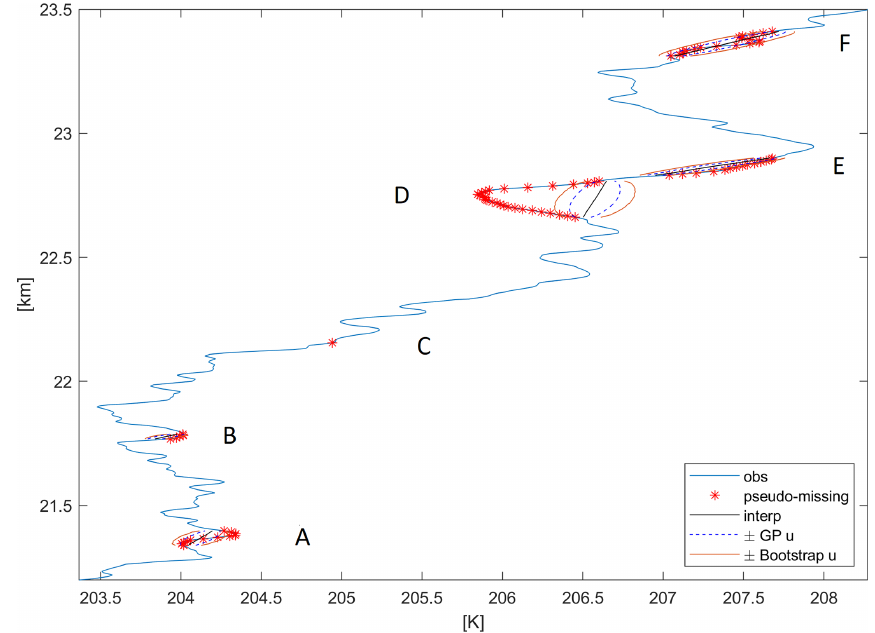
Figure 13. Detail of the RS42 temperature profile at the Sodankylä site on 3 March 2017 12:00UTC, around 22.5km altitude. Observations are in blue, block-bootstrap pseudo-missing are in red, and the corresponding five gaps are labelled A–F; linear interpolation is in black; ± GP uncertainty, Eq. (8), is in dashed blue; ± Bootstrap-corrected uncertainty, Eq. (15), is in